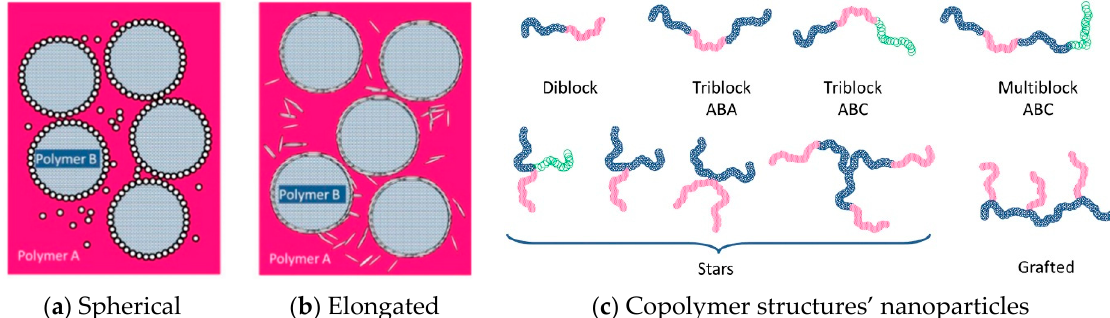
Figure 3. Presentation of compatibilizer shapes and molecular architectures for ( a ) spherical nanoparticles ( b ) elongated nanoparticles ( c ), copolymer structures: diblock copolymer consisting of two homopolymer blocks, triblock copolymers consisting of three homopolymer blocks, multiblock copolymer consisting of four or more homopolymer blocks, star copolymers consisting of polymeric chains attached to a central core, and grafted copolymers consisting of main homopolymer chain with different polymeric side chains. Reproduced with permission [40].